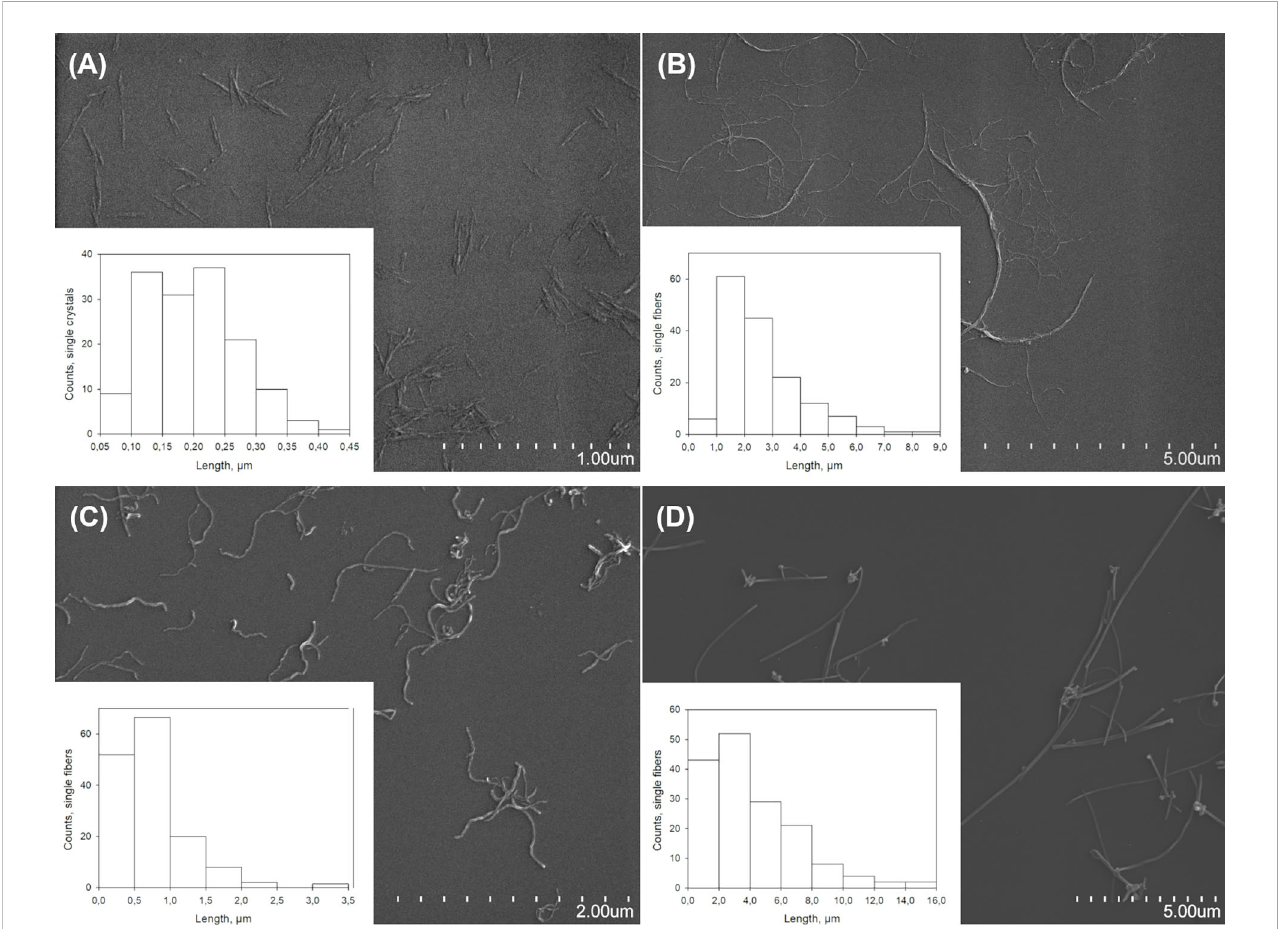
FIGURE 1 Characterization of nanomaterials. Representative SEM images and length measurements in µm of (A) CNC, (B) CNF, (C) NM-400, and (D)